Question: Which kind of chart has been used to present this data?
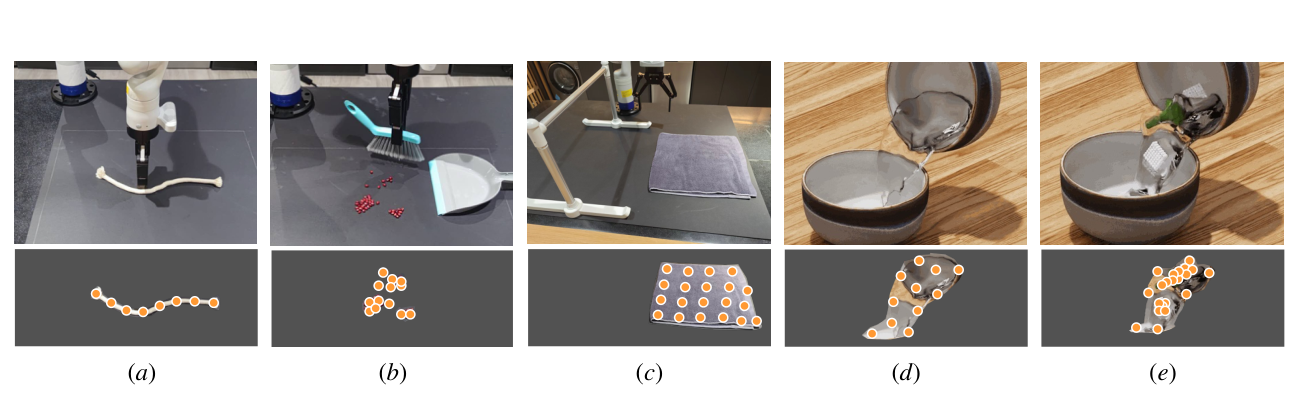
Answer: scatter